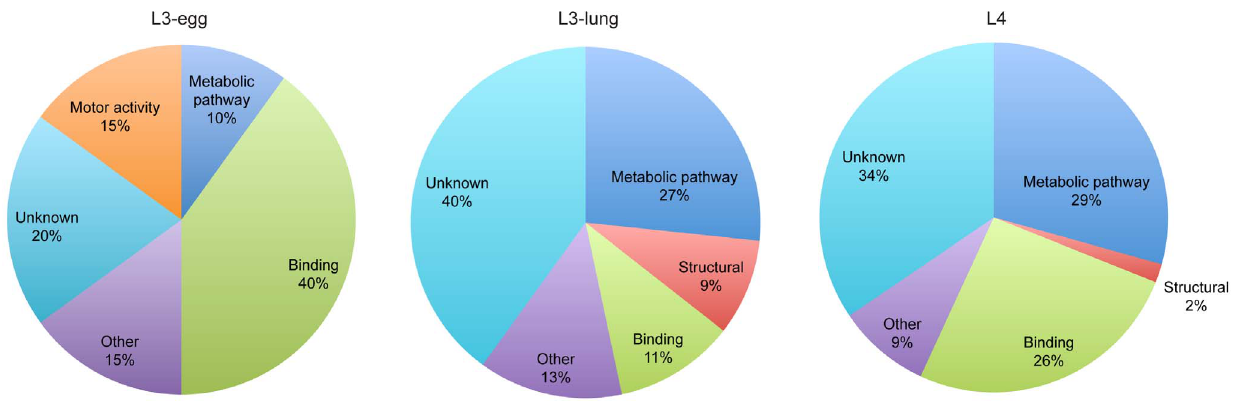
Figure 3. Gene ontology. Gene Ontology terms relating to molecular function assigned to the proteins identified in ES products from L3-egg, L3- lung and L4 of A. suum